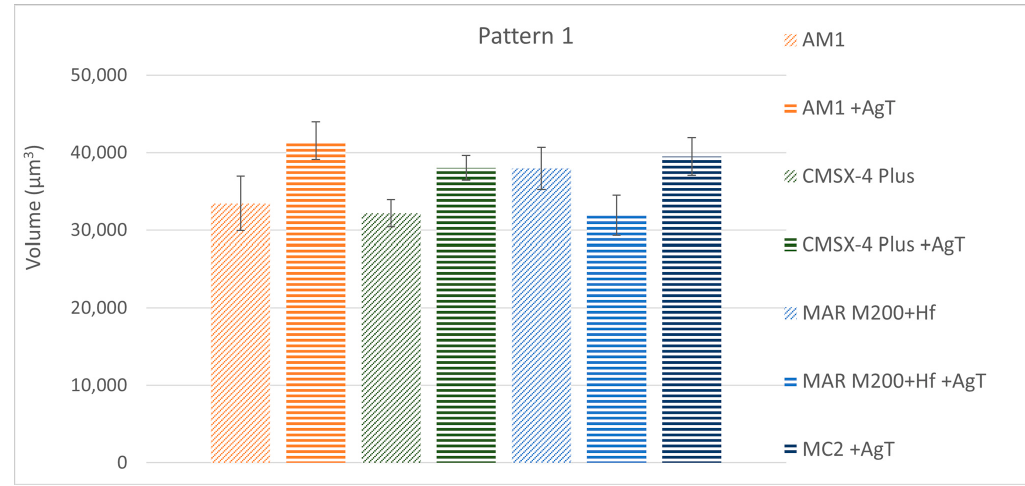
Figure 9. Thermally affected volumes of textured pattern 1 on different Ni-based single crystal superalloys.